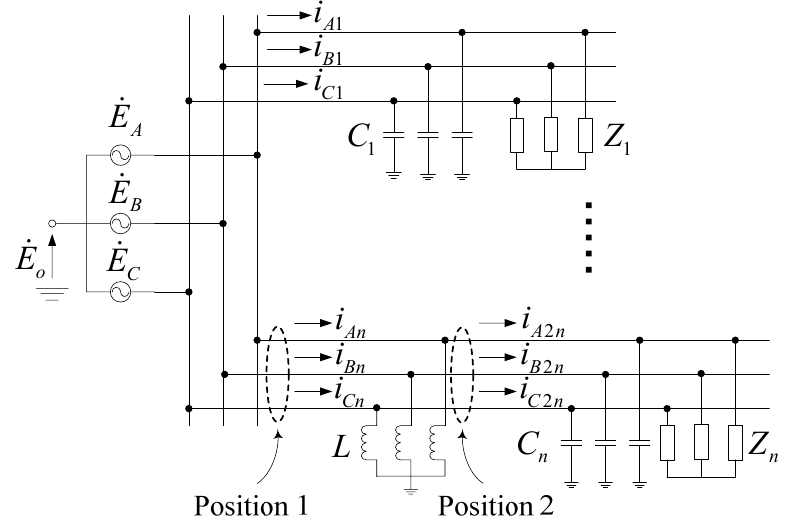
Figure 14. The equivalent circuit of PT’s ferroresonance of isolated neutral